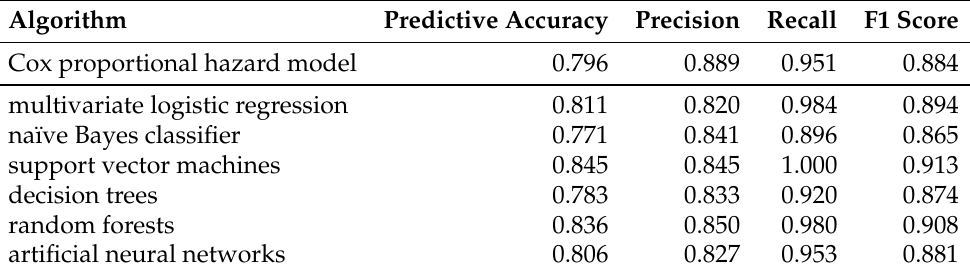
Table 3. Predictive accuracy, precision, recall and F1 score of COVID-19 IgG antibody blood level decrease below laboratory cut-off’s estimation for the listed algorithms, both traditional Cox’s model and classifiers using a decomposed time-to-event variable, calculated using 10-fold cross-validation.